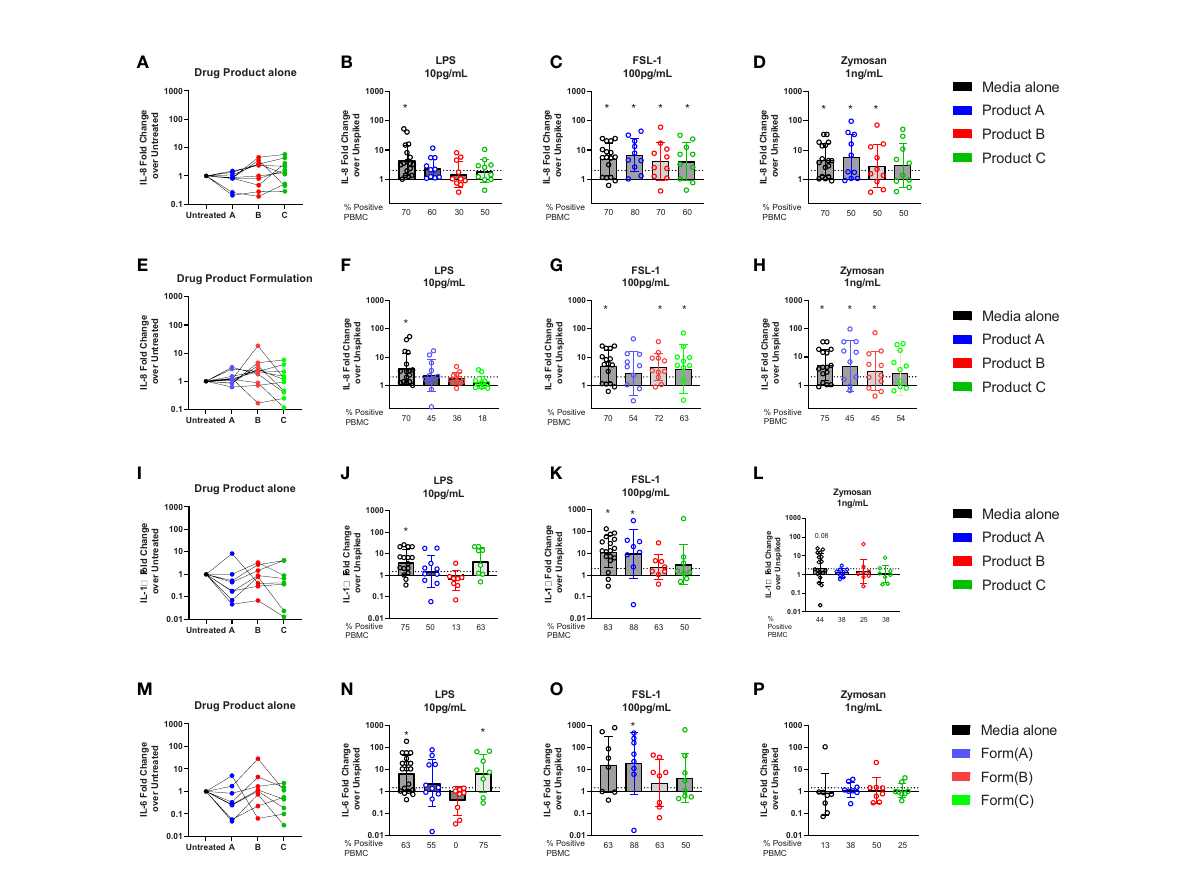
FIGURE 6 Impact of drug formulations on PBMCs in vitro detection of IIRMI. PBMCs were stimulated for 24h with LPS (10pg), FSL (100pg), or Zymosan (1ng) in media alone, drug product or the corresponding formulation (10% v/v) for 3 licensed or approved products. Fold changes in IL-8 gene expression are relative to the unspiked cells. Fold increase in mRNA for IL-8 (A – E) , IL-6 (I) , and IL-1 b (M) expression by PBMC treated with drug product (B-D, J-P) or drug formulation (F-H) (10% v/v) unspiked or spiked with TLR agonists. N=8-18 PBMC from healthy donors per condition. Donors were considered positive if the level of mRNA expression was ≥ 2-fold increase over the unspiked control; the percentage of positive PBMC in each condition is presented under each graph. * indicated p < 0.05 and is a comparison between the expression in cells stimulated with a model IIRMI in media, drug products, or drug formulation and the corresponding unspiked